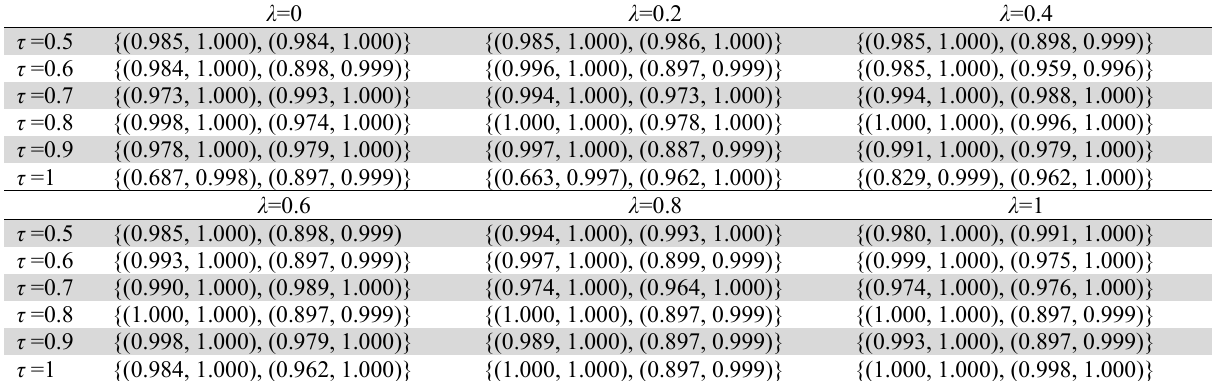
The satisfaction degree of each objective for LAM and UAM Corresponding equivalent single objective for different values of parameters λ and τ